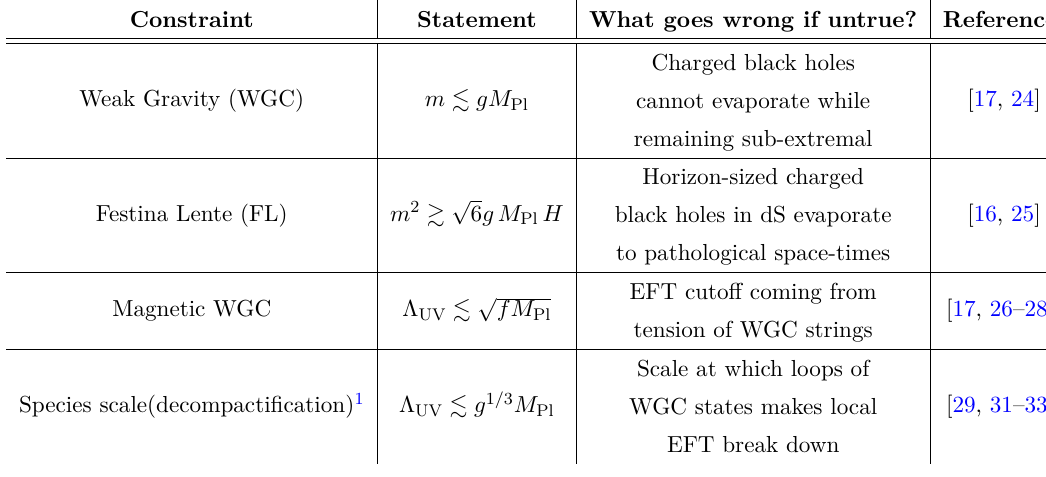
Table 1 . Brief summary of Swampland results used in this